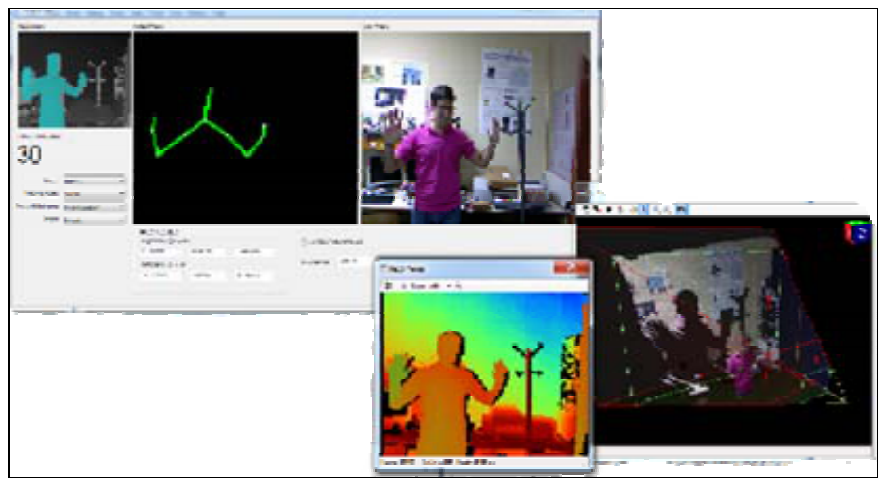
Figure 3. Kinect TM user